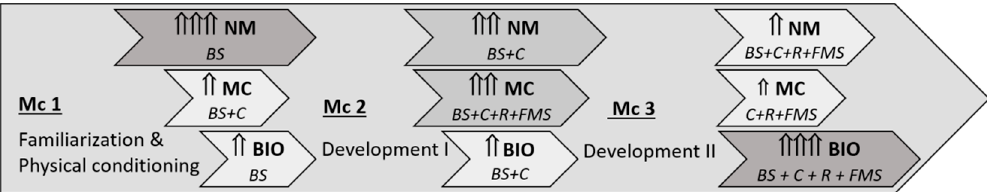
Figure 3. EFAM-UV © periodization. Guidelines of the 3 main mesocycles (Mc) in the 8-months macrocycles used in this study. Horizontal arrows represent the changes in the motor domain and contents’ orientation (NM: neuromuscular; MC: motor control; BIO: bioenergetic), with the length pointing out its beginning and end during the mesocycle. It includes the dimensions to develop in each of them (BS: basic skills; C: complementary skills; R: rhythm; FMS: functional motor skills). The vertical small arrows (and colours) reflect the prevalence and importance of each motor domain.